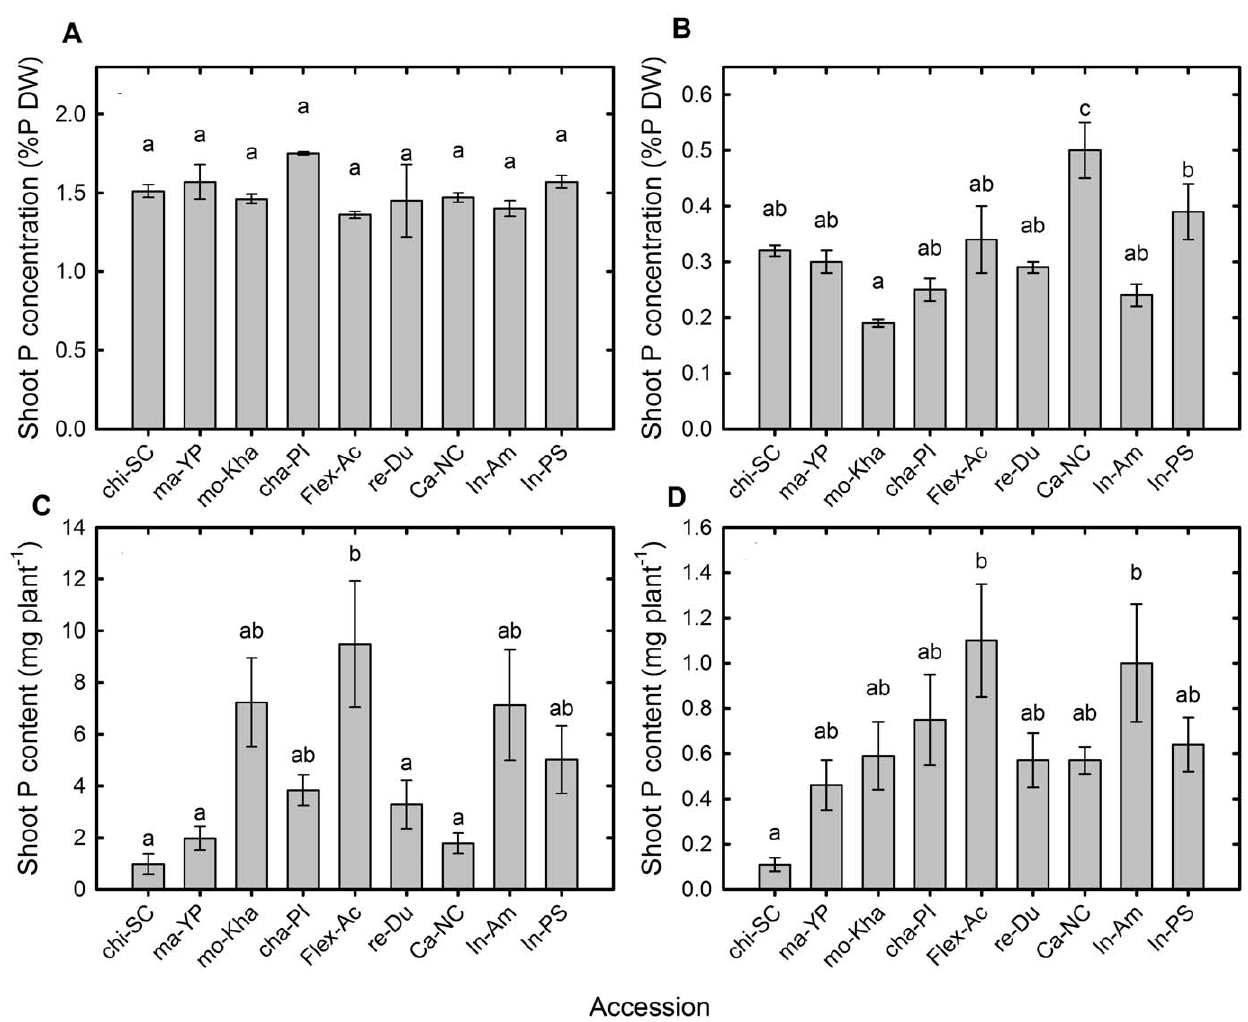
Figure 2. Phosphorus content in shoots of nine melon accessions grown hydroponically under P replete and P starved conditions. Mean (a,b) shoot P concentration and (c,d) shoot P content for melon accessions grown hydroponically with a full nutrient solution (Control, a,c) or nutrient solution containing no phosphate (NoP, b,d) for 21 d. Each bar represents the mean 6 se (n=9). Bars with the same letter are not significantly different at P , 0.05 by Newmans Keuls multiple range